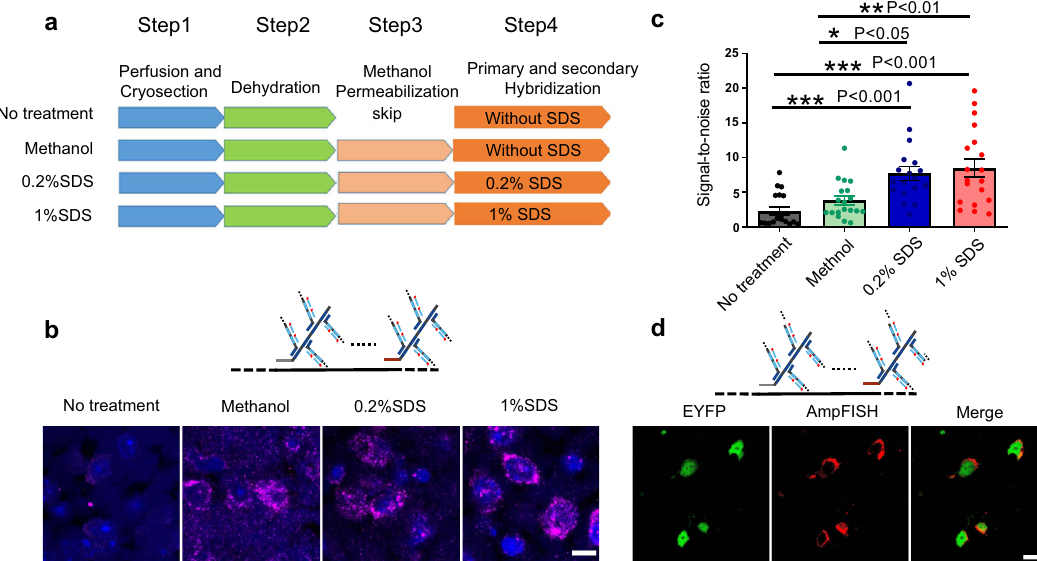
Fig. 4 AmpFISH is adopted to robustly assay transcripts in mouse brain slices. a Schematic diagram depicting four different experimental work fl ows. b FISH imaging of Gad1 gene in mouse brain slices using different pipelines depicted in ( a ) (scale bar: 10 μ m). c Statistical analysis of signal-to-noise ratio (SNR) of AmpFISH from four experimental pipelines in ( b ). The intensity of an area as background signal next to the signal was subtracted from the signal itself. The signal-to-noise ratio was determined by formula: (Signal-background)/background. One-way analysis of variance (ANOVA), F (3, 72) = 10.83, P < 0.0001; Bonferroni ’ s multiple comparison test, no treatment vs. 0.2% SDS, t = 4.206, P < 0.001; no treatment vs. 1% SDS, t = 4.810, P < 0.001; methanol vs. 0.2% SDS, t = 3.030, P < 0.05; methanol vs. 1% SDS, t = 3.633, P < 0.01. ( n = 19, from three repeat experiments). d The speci fi city of AmpFISH via secondary ampli fi cation hybridization was veri fi ed in brain slices by expressing EYFP protein in Thy -EGFP transgenic mouse (scale bar: 25 μ mouse. Figure 4d (left panel) shows that the fl uorescence signal of EGFP was retained through treatment with 1% SDS and 100% methanol, allowing to assess the accuracy of AmpFISH by analyzing the distribution of AmpFISH signal and fl uorescence signal from proteins in the same slice. Figure 4d (middle and right panels) show that the AmpFISH signal (red) perfectly matched with the EGFP fl uorescence (green) in the same cells, demon- strating that the AmpFISH work fl ow that we developed exhibited speci fi city in the brain slices.